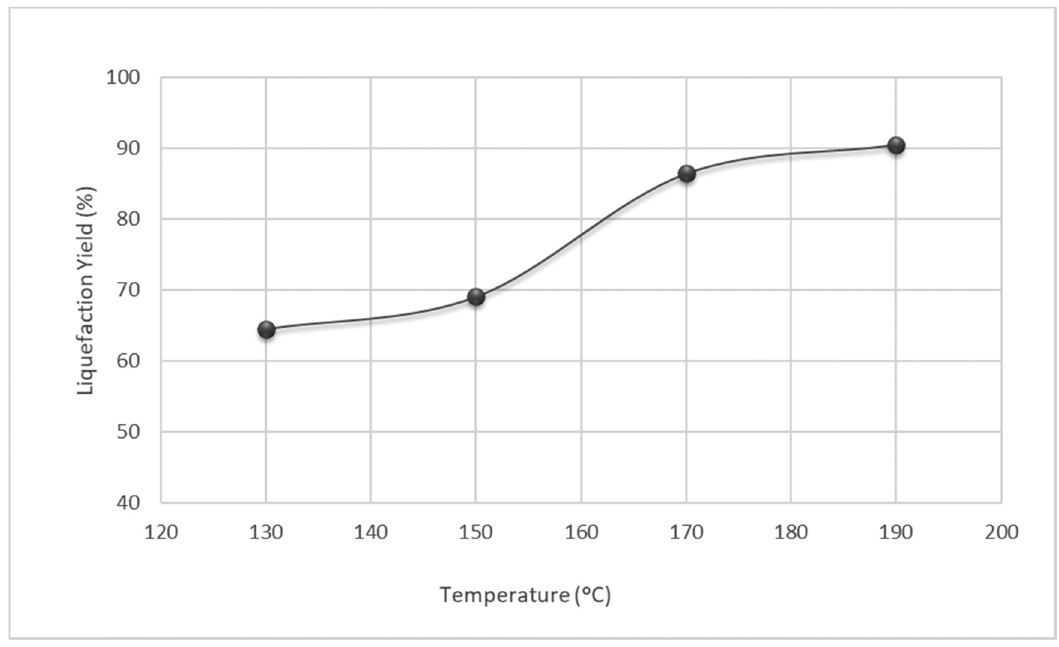
Figure 2: Liquefaction yield ( % ) with temperature ( °C ) for